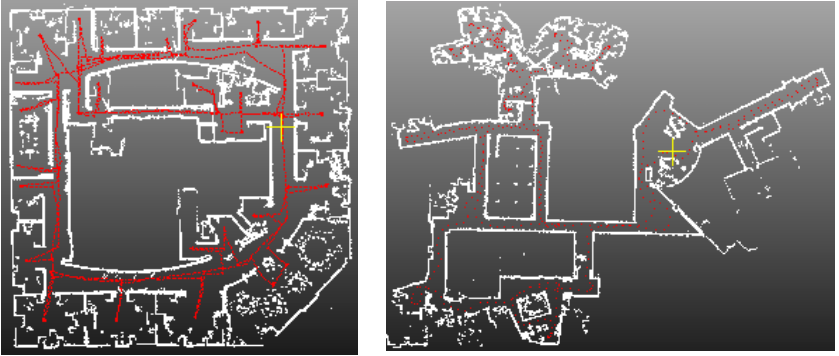
Figure 14. The final results of Intel and MIT datasets. ( Left ) Intel; ( right ) MIT.